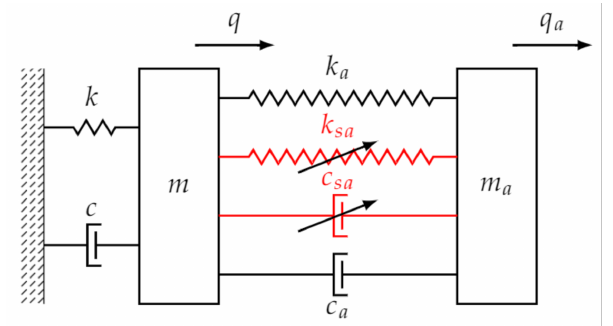
Figure 5. Sketch of a